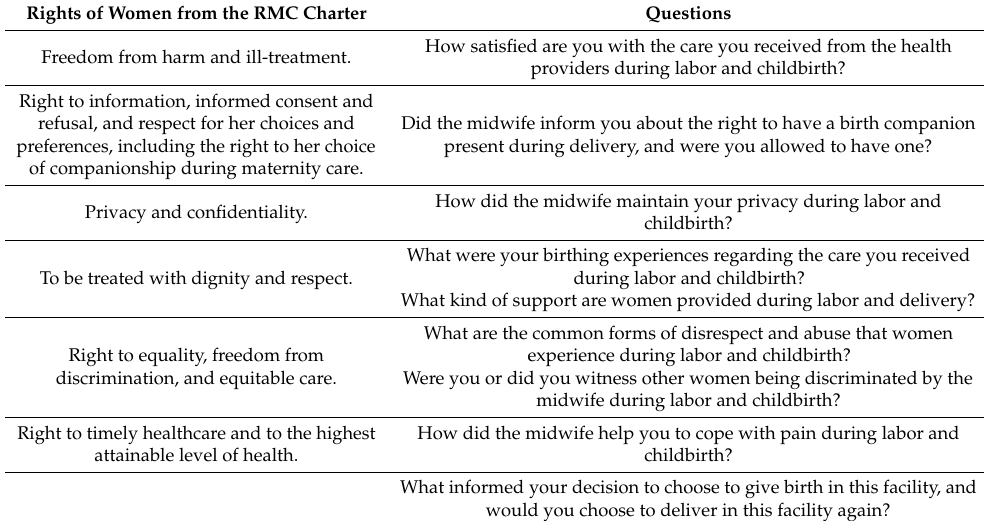
Table 1. Questions from the interview guide. RMC: Respectful Maternity